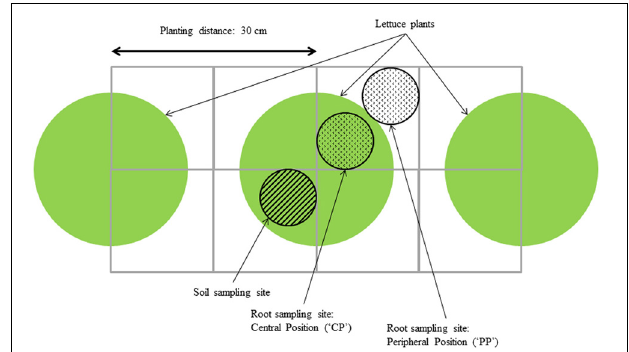
FIGURE 1 | Root and soil sampling scheme, adapted from Van Noordwijk et al.